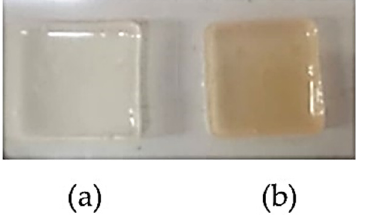
Figure 2. The optimized films ( a ) before and ( b ) after crosslinking at 130 °C for 30